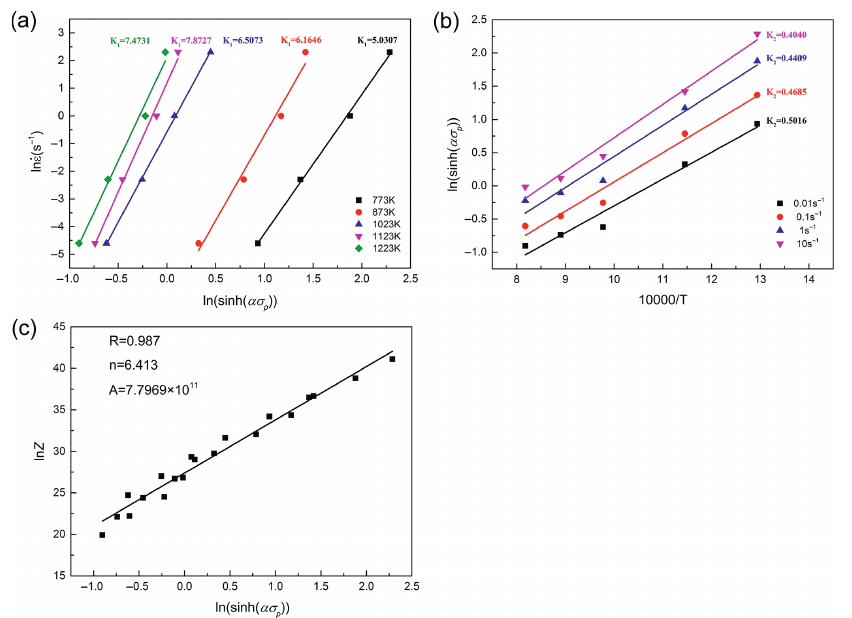
Figure 12: (a) Plot of ln _ ε versus ln(sinh( ασ p )) (b) plot of ln(sinh( ασ p )) versus (10,000/ T ), (c) variation of the Zener – Hollomon parameter with flow stress.